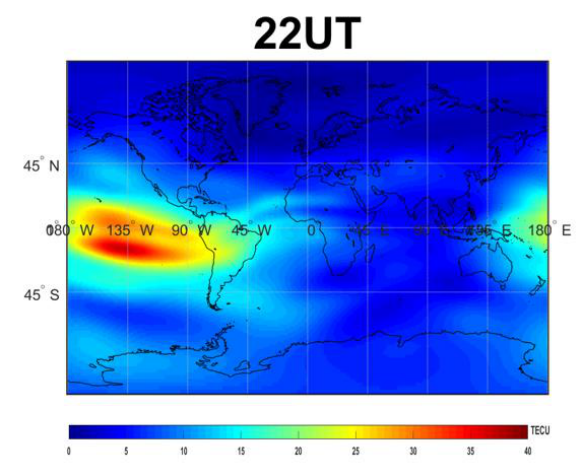
Figure 4 . VTEC-Map at UT = 22 on 1 st January